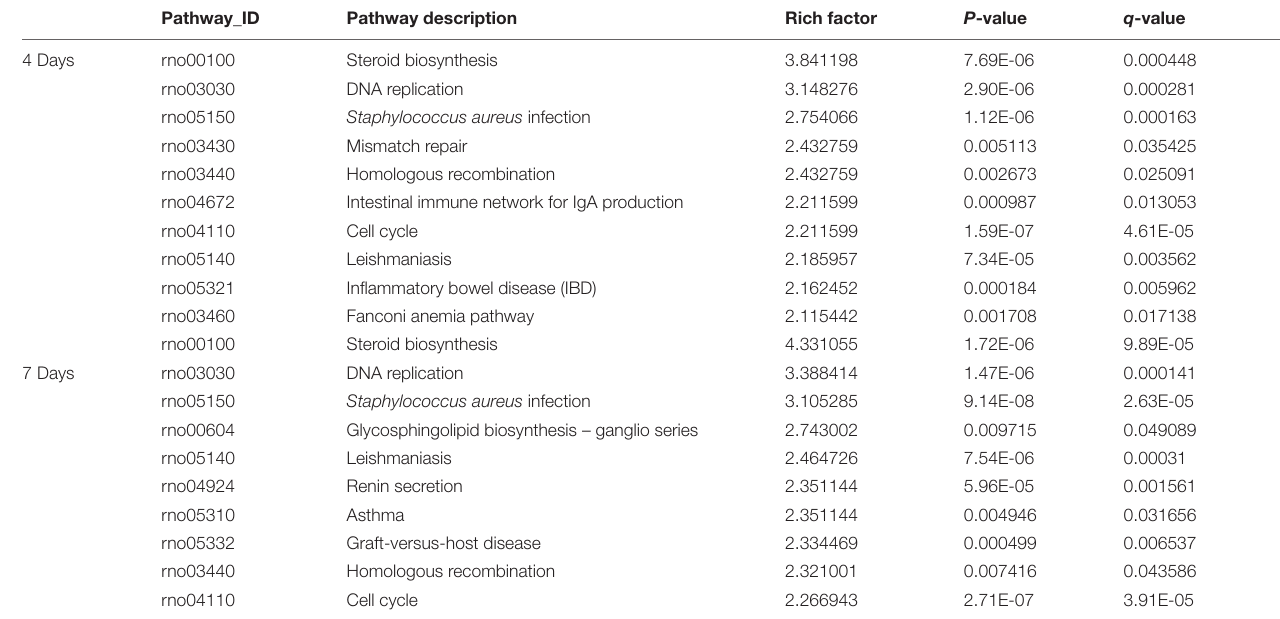
TABLE 7 | The classification corresponding to the top 10 DEmRNAs at 4 and 7 days after sciatic nerve crush injury in SD rats in the KEGG